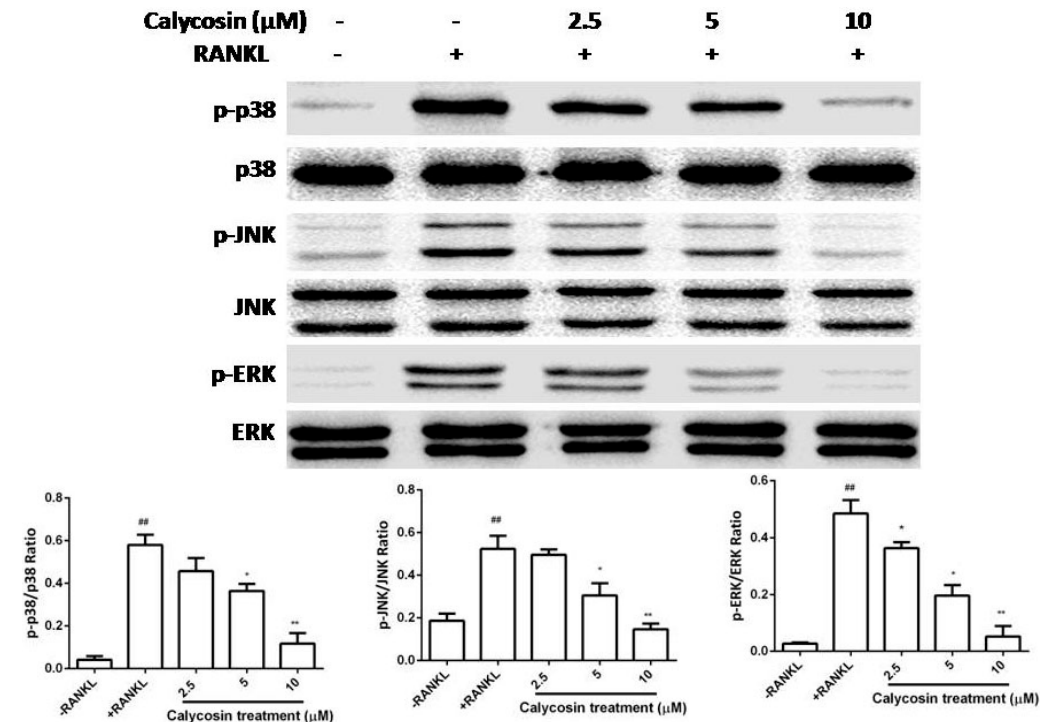
Figure 6. Effects of calycosin on the phosphorylation of MAPKs by RANKL. BMMs were pretreated with the indicated dose of calycosin or DMSO (vehicle) for 20 min, then RANKL (20 ng/mL) was added for30 min. The relative quantification of target proteins was calculated by comparison of the bands density levels between samples. The values shown in the graphs were the mean ± SD ( n = 3). ## p < 0.001 vs. vehicle-treated group; * p < 0.05 and ** p < 0.01 vs . RANKL-treated group.